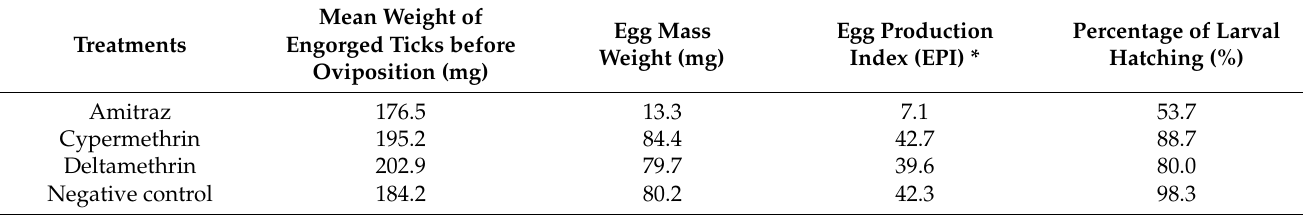
Table 2. Reproductive parameters of R. microplus ticks after the adult immersion test with different acaricidal acaricide products .